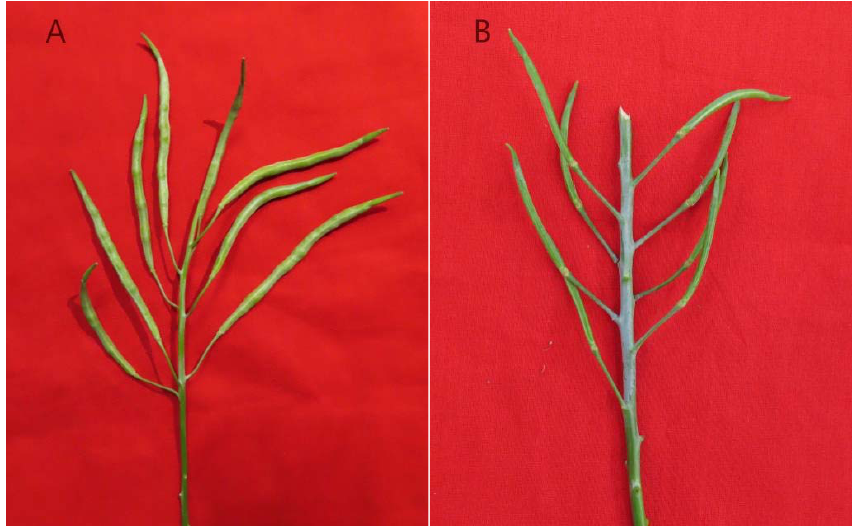
Figure 1. Pod enlargement of self ‐ compatibility lines 18 ‐ 493 ( A ) and self ‐ incompatibility lines 18 ‐ 551 ( B ) in the open flower stage.